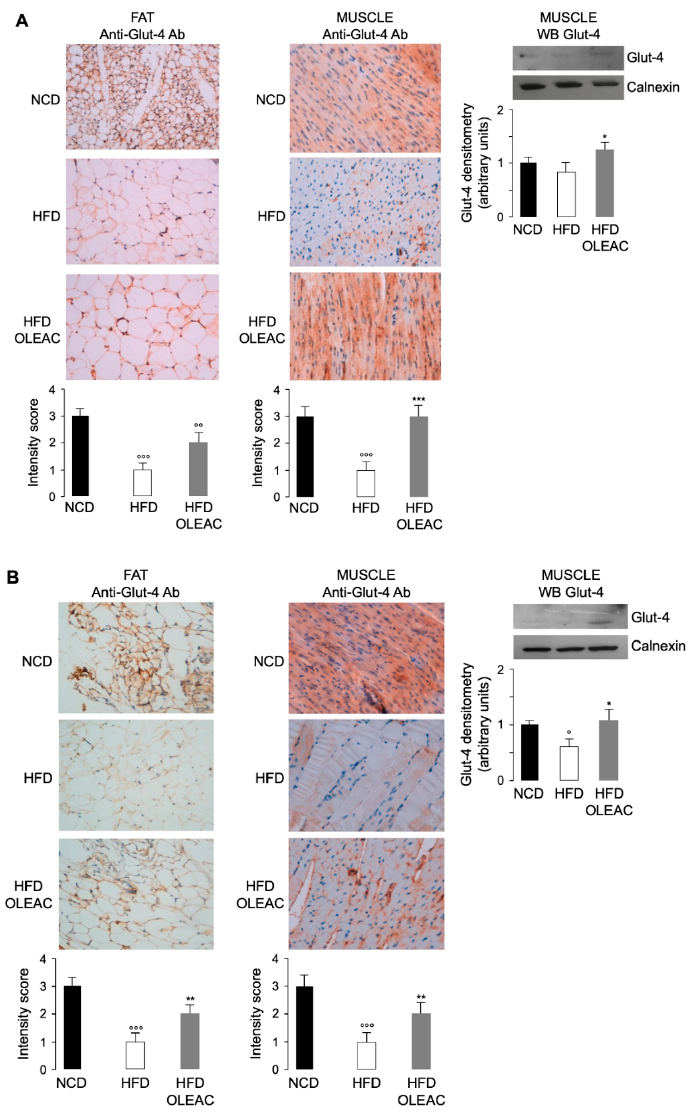
Figure 3. Effects of oleacein on Glut-4 expression. Representative images of immunostaining for Glut-4 in the abdominal fat tissue (200× magnification) and muscle tissue (400× magnification) of